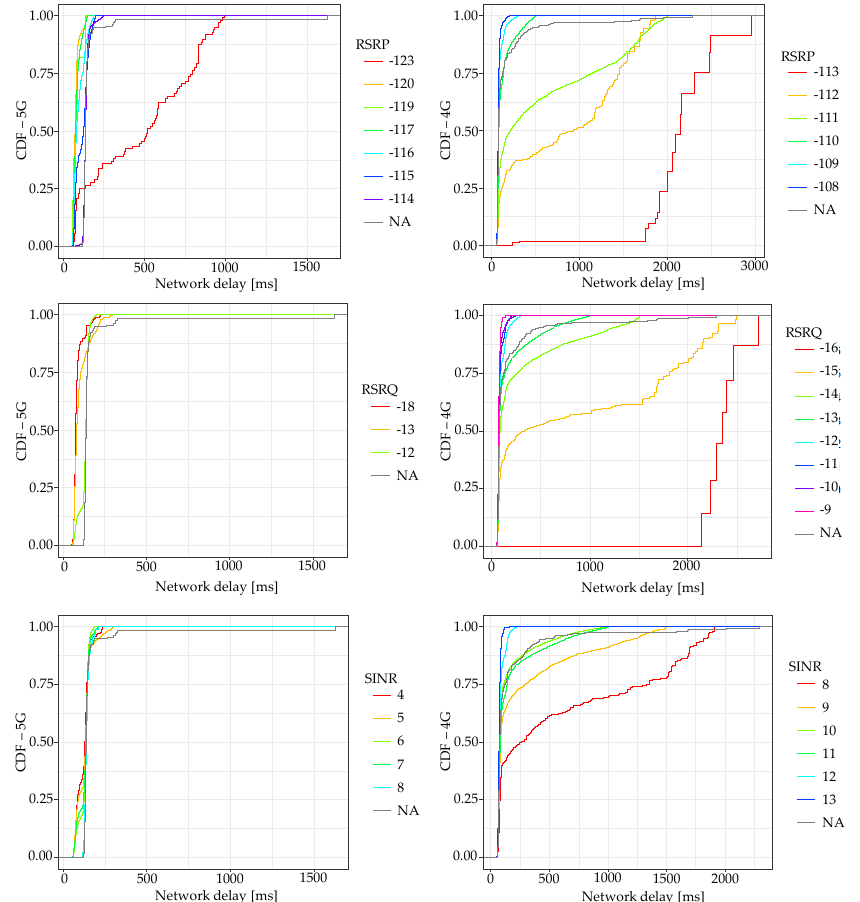
Figure 7. RSRP, RSRQ and SINR measured CDF for 4G ( right ) and 5G ( left